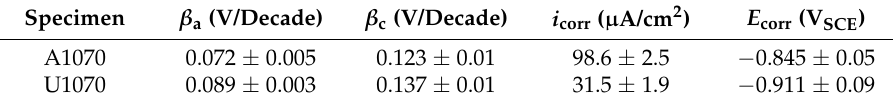
Table 6. Parameters extracted from electrochemical impedance spectroscopy (EIS) data of A1070 and U1070.